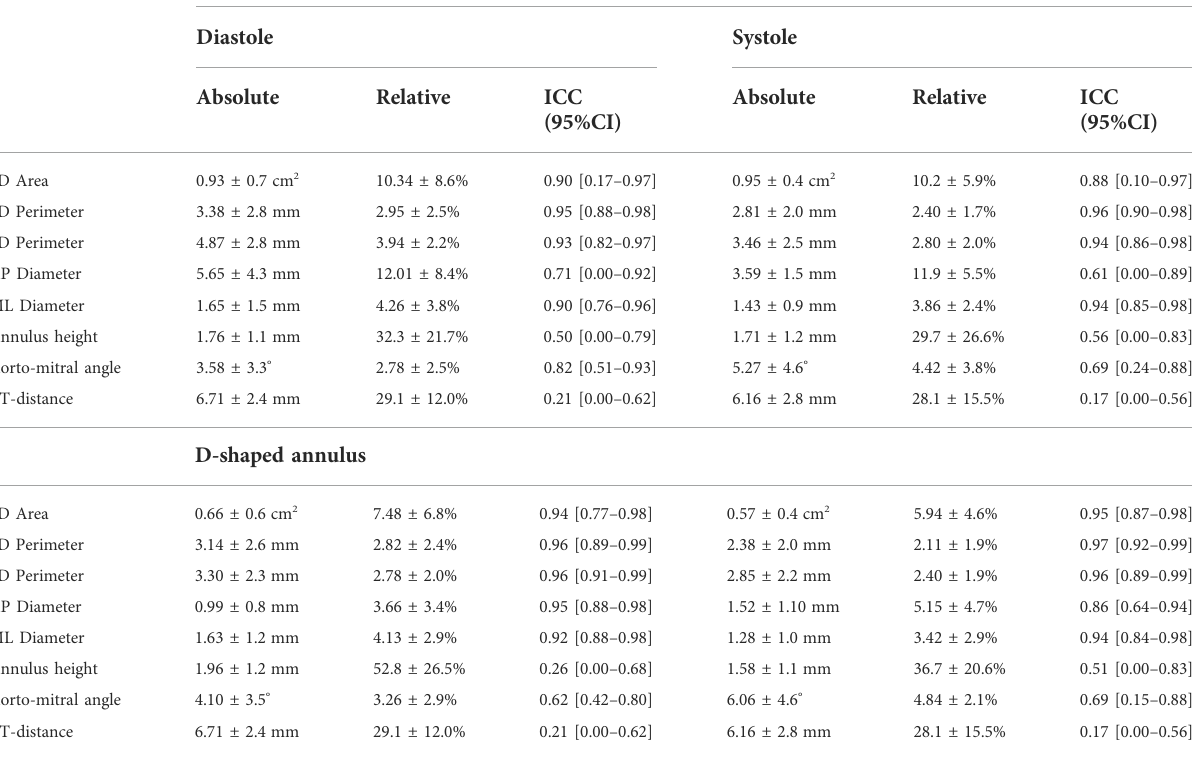
TABLE 3 Inter-method variability for mitral valve